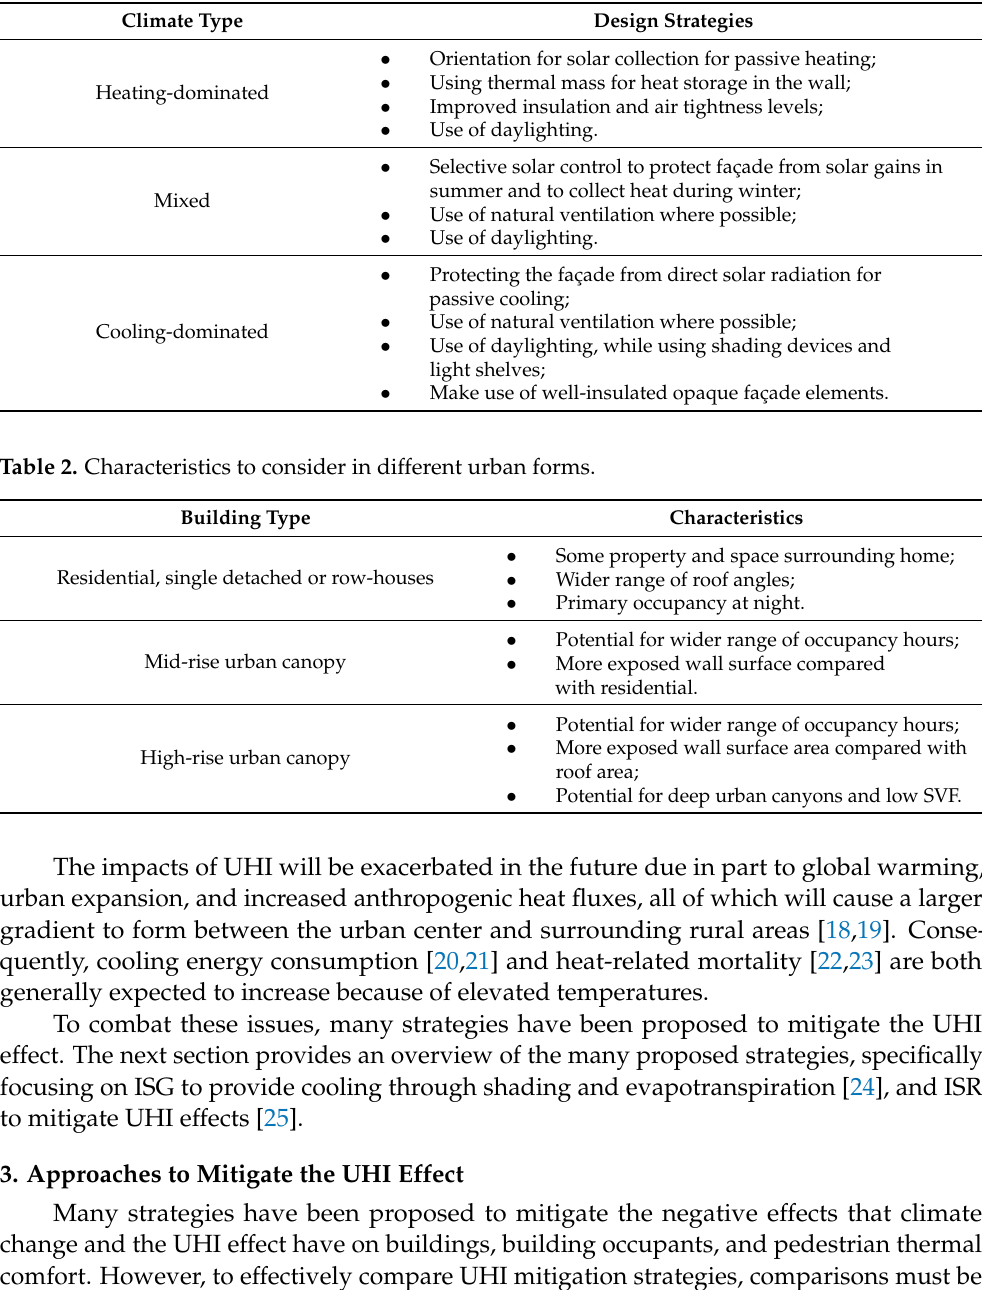
Table 1. Passive design strategies for sustainable building design based on climate.